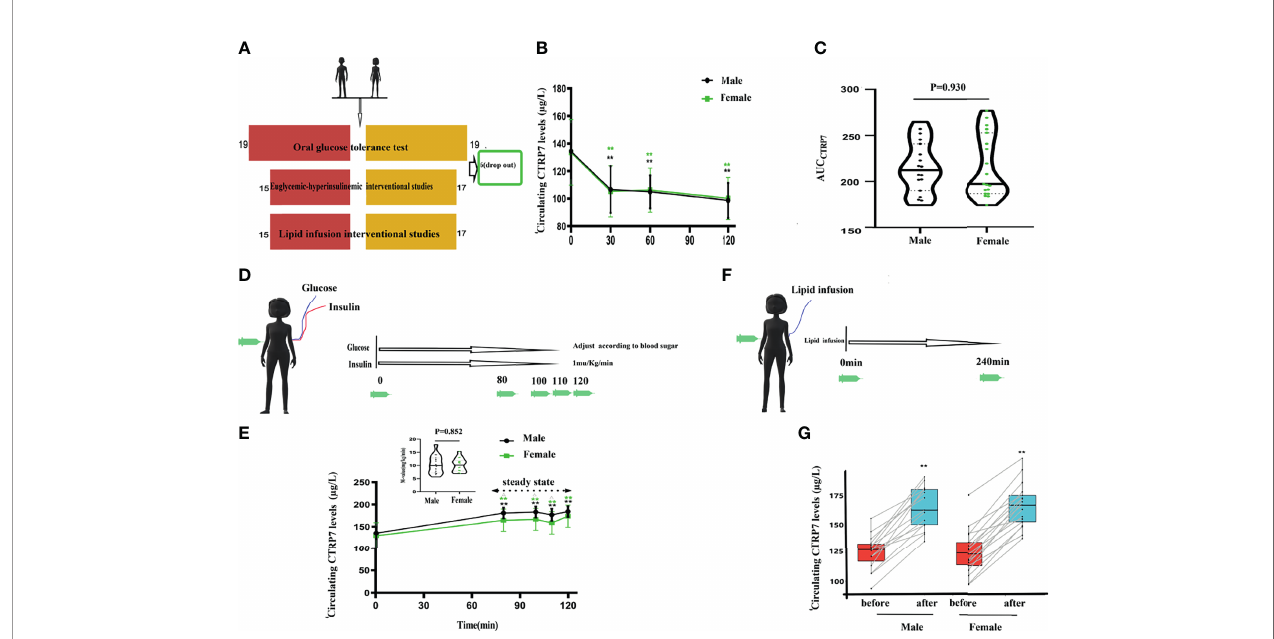
FIGURE 2 | Circulating CTRP7 levels in the interventional studies of healthy individuals. (A) Schematic diagram of intervention study design. (B) Circulating CTRP7 concentrations during the OGTT. (C) Area under the curve of CTRP7 during the OGTT (AUC CTRP7 ). (D) Schematic diagram of the EHC. (E) Time course of serum CTRP7 alternations in healthy individuals during the EHC. (F) Schematic diagram of lipid infusion. (G) Time course of serum CTRP7 alternations in healthy subjects during lipid infusion. OGTT, oral glucose tolerance test; HEC, hyperinsulinemic-euglycemic clamp. Data are means ± SD. ** p < 0.01 vs. baseline, or